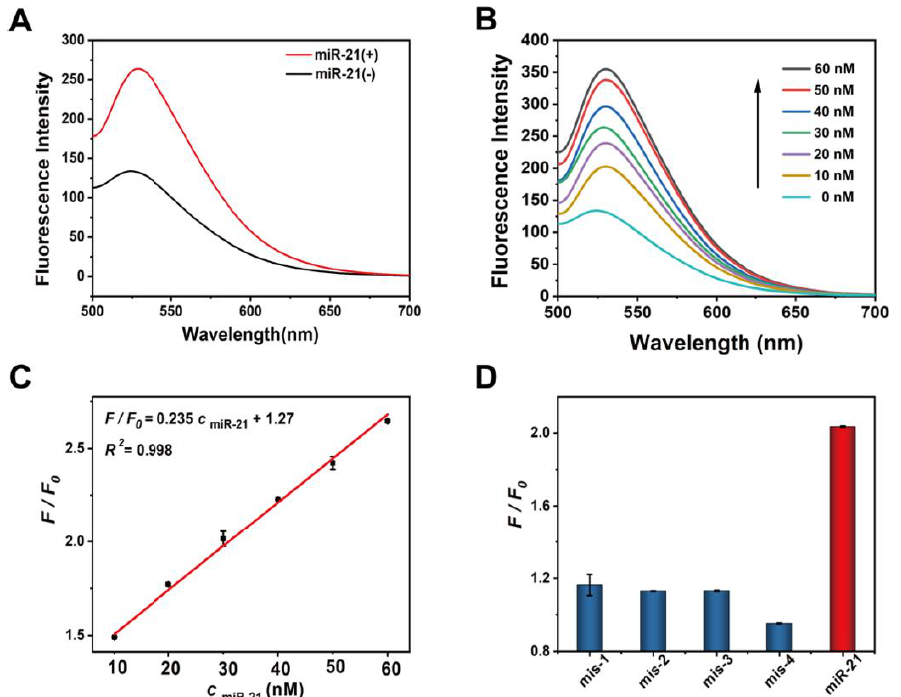
Figure 5. ( A ) The feasibility for the detection of miR-21 with the DNAzyme amplification strategy. ( B ) Fluorescence emission spectra of DNAzyme amplifier in the presence of different concentrations of miR-21 (from bottom to top: 0 nM, 10 nM, 20 nM, 30 nM, 40 nM, 50 nM, and 60 nM). ( C ) The linear relationship between F / F 0 and the concentration of miR-21. ( D ) Selectivity for the detection of miR-21. Error bars represented the standard deviation of three determinations. Experimental conditions: substrate concentration of 25 nM, DNAzyme concentration of 25 nM, blocker concentration of 30 nM, Mn 2+ concentration of 750 μM , 25 mM Tris-HCl buffer (containing 137 mM NaCl, pH 7.0).